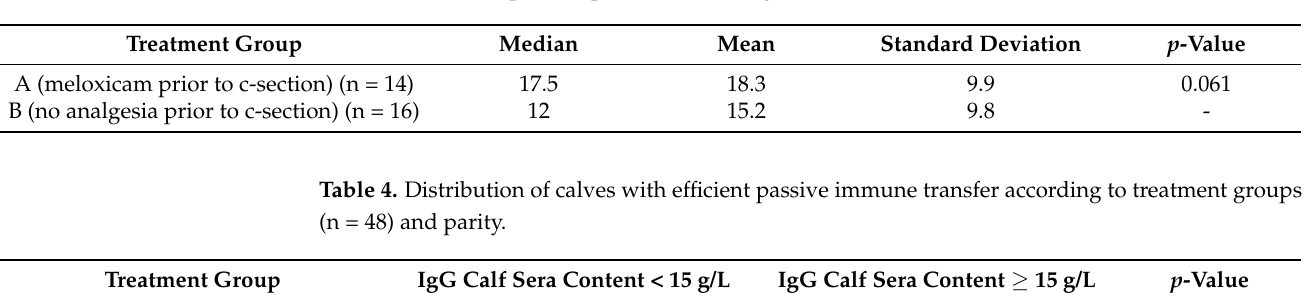
Table 3. Distribution of the quantitative IgG sera calf content (g/L) according to treatment group (n = 30 calves with precise quantification of IgG content).